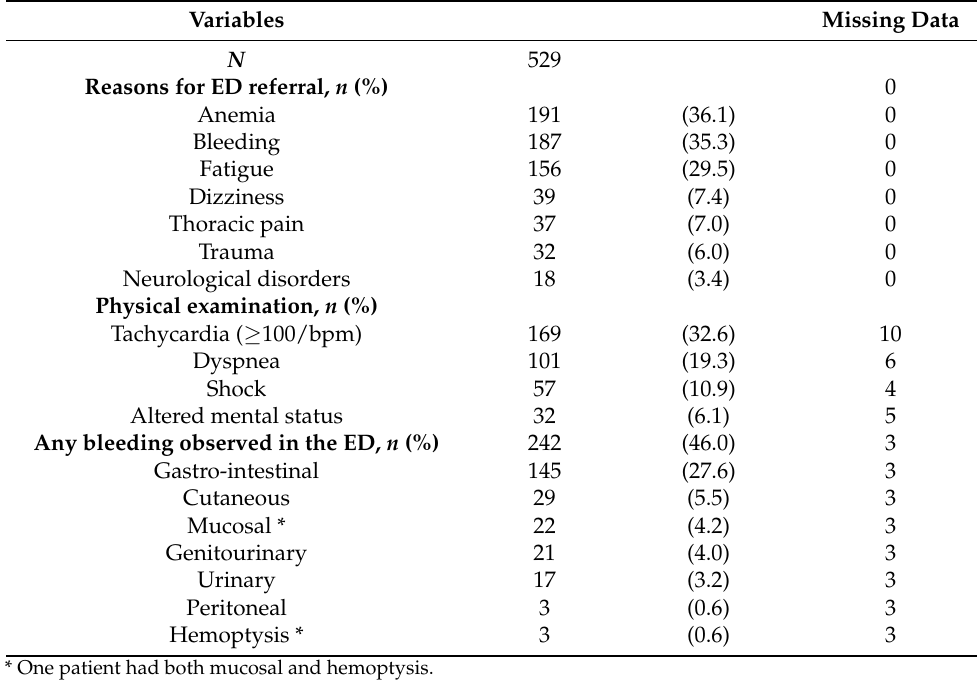
Table 2. Reasons for ED referral and clinical exams at arrival of patients transfused with red blood cells in the ED.